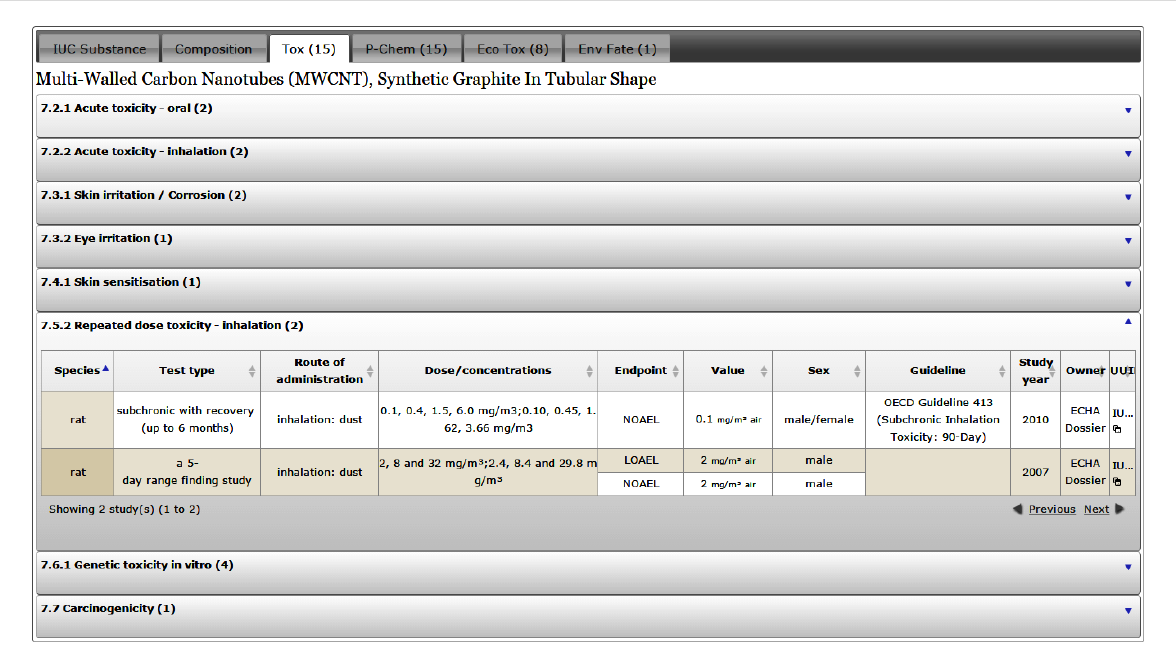
component and highlighting the results as a core, coating